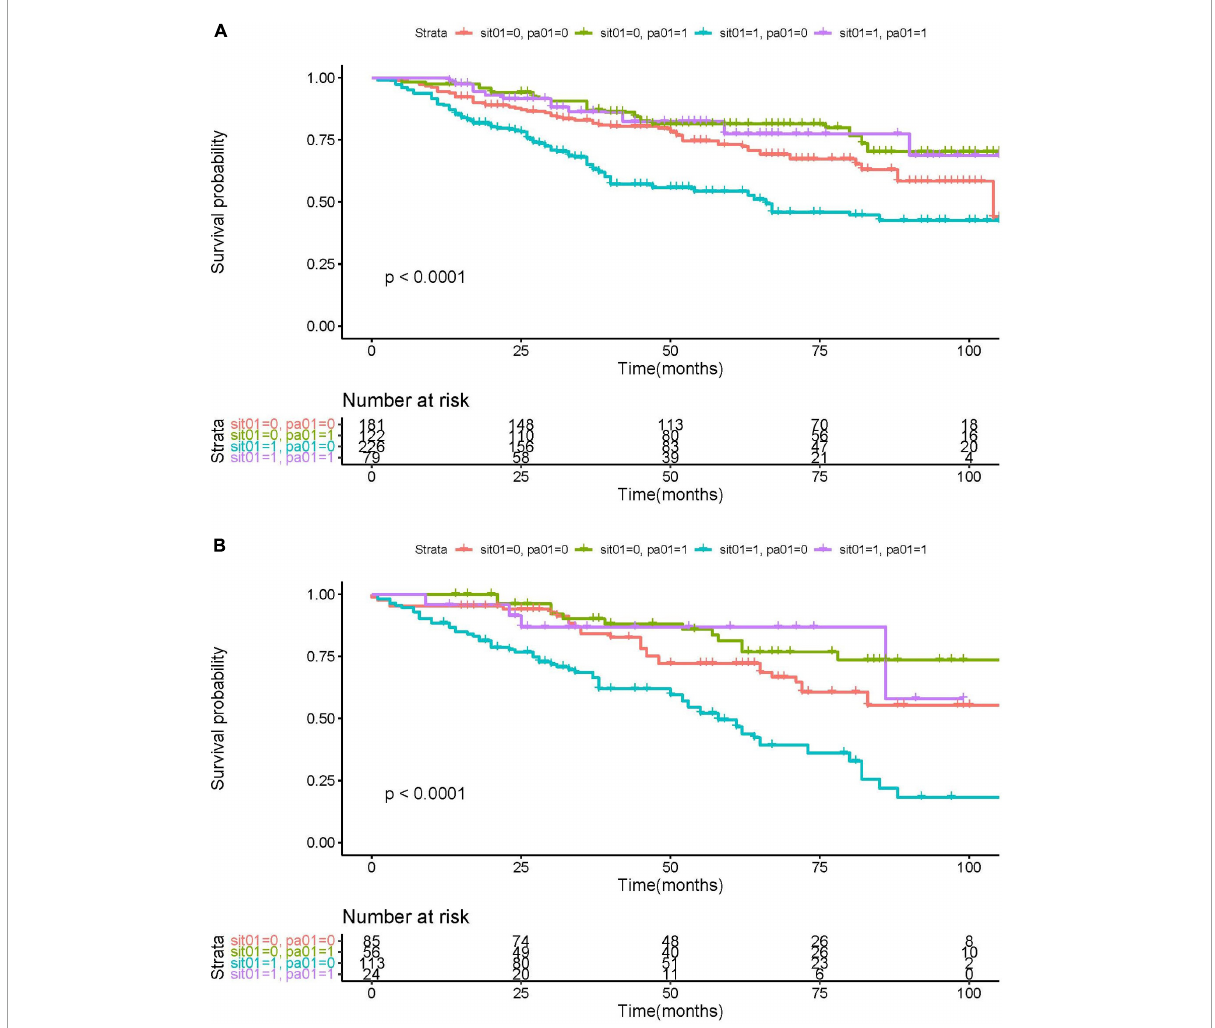
FIGURE3 KM survival curve for NYHA I/II group (A) and NYHA III/IV (B) , sorted by physical activity (PA) and sedentary behavior (SB). Red curve: without PA or SB (“sit01” = 0, “pa01” = 0); green curve: PA without SB (“sit01” = 0, “pa01” = 1); blue curve: SB without PA (“sit01” = 1, “pa01” = 0); purple curve: PA with SB (“sit01” = 1, “pa01” =